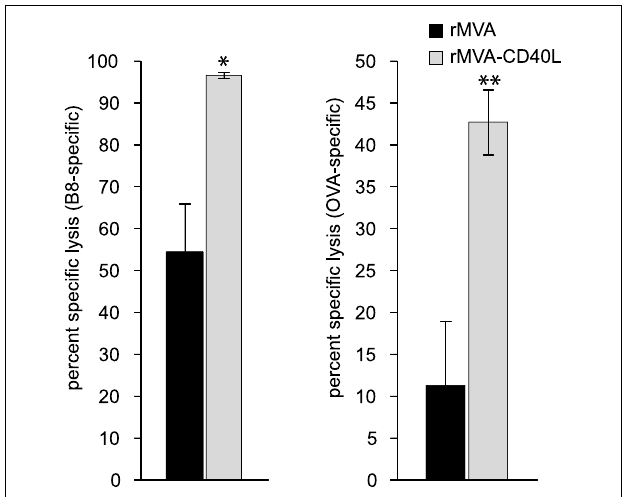
FIGURE 10 | Heightened CTL activity in rMVA-CD40L immunized mice . In order to characterize the lytic activity of B8- and OVA-specific CD8T cells, an in vivo CTL assay was performed on day 56 after immunization. Unpulsed (CFSElow), B8 20–27 -peptide pulsed (CFSEhigh) and OVA 257–264 -peptide pulsed (eFluor670high) splenic target cells were injected into rMVA and rMVA-CD40L immunized mice. Four hours post-transfer the ratio of unpulsed and peptide pulsed target cells was determined and the percent specific lysis calculated.Values represent mean ± SEM specific lysis of target cells of four mice per group.The experiment was performed twice with similar